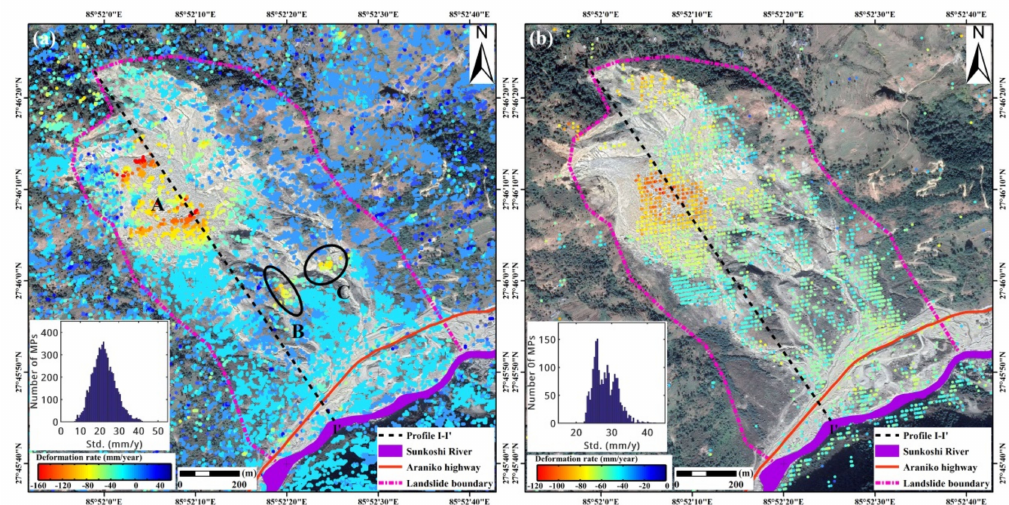
Figure 6. Post-disaster annual mean LOS deformation rate of Sunkoshi landslide measured by ( a ) ALOS-2 data during the period from September 2014 to October 2017, and ( b ) Sentinel-1 data during the period from January 2017 to October 2019. The repaired road and dredged river are also rendered. The subfigures on the lower-left corner show the histograms of standard deviation distribution of deformation